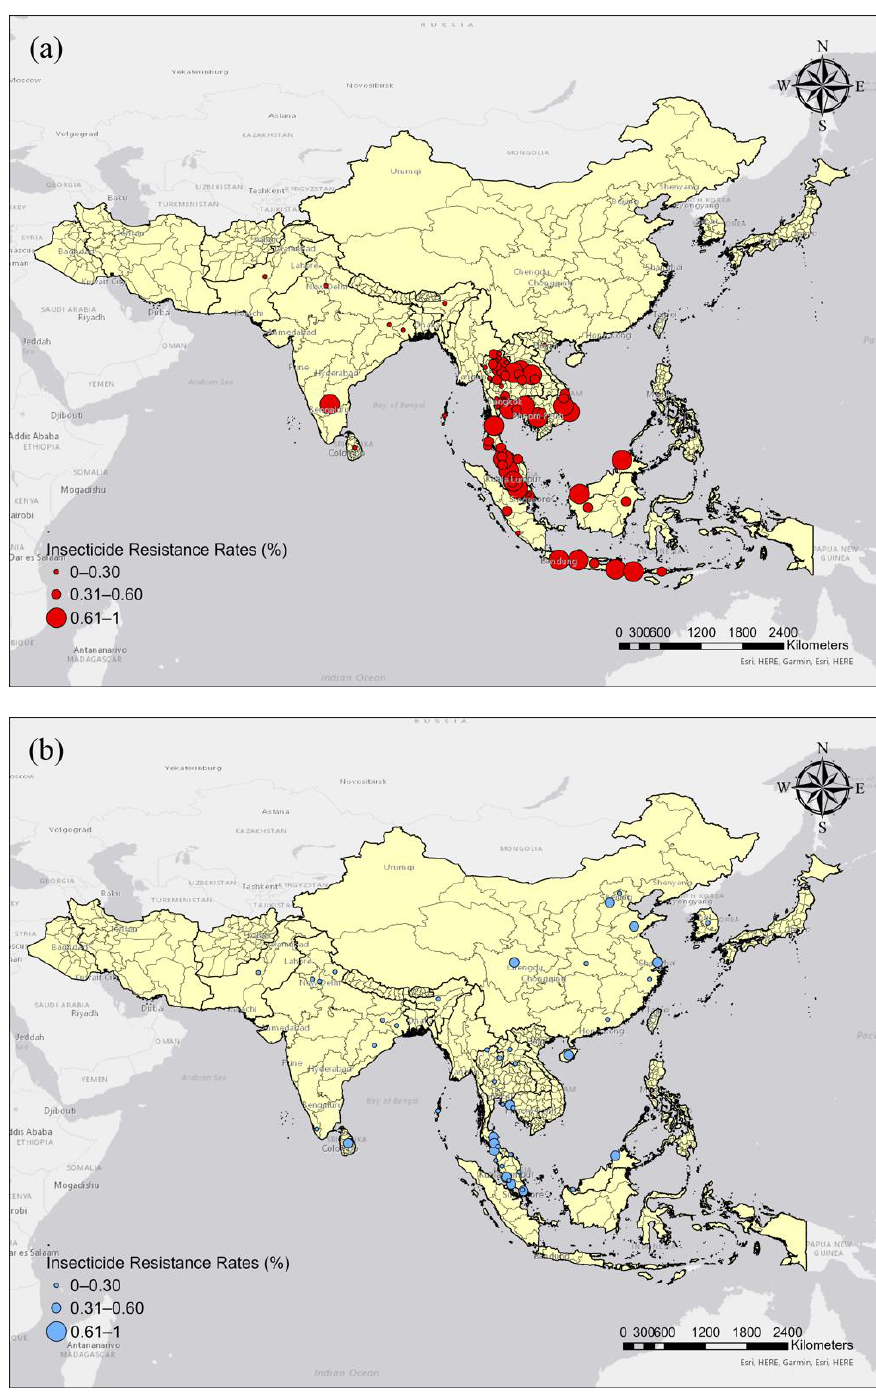
Figure 4. Spatial distribution of insecticide resistance in Aedes mosquitoes. ( a ) Ae. aegypti . ( b ) Ae. albopictus. The sizes of the circles correspond to the insecticide resistance rates. The sizes of the circles correspond to the insecticide resistance